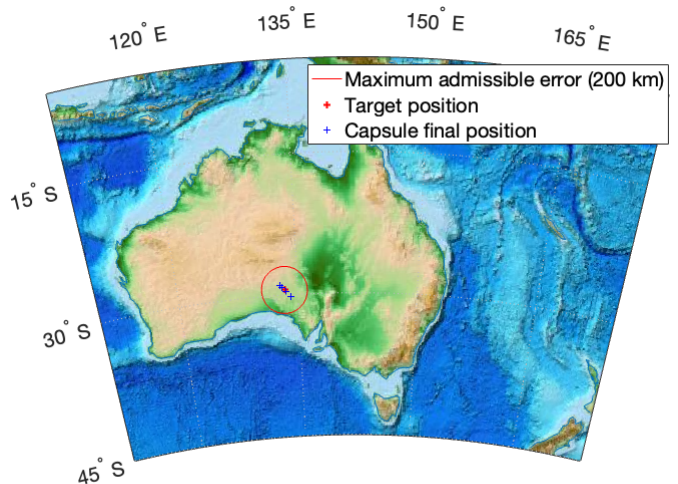
Figure 7. Actual and target position comparison. The target point (red cross) is located in the Great Victoria Desert, Australia. The blue cross denotes the capsule actual position for the simulation scenarios in Table 5.